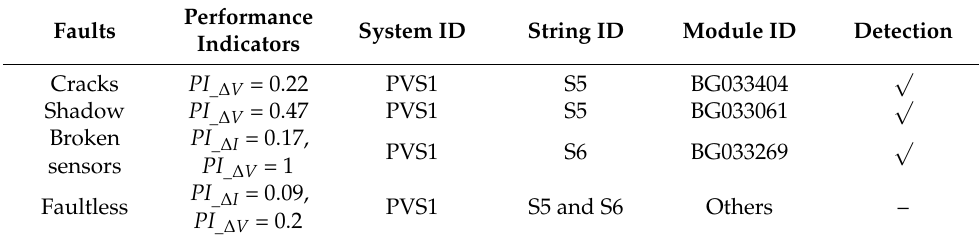
Table 2. Results of faults detection in PV